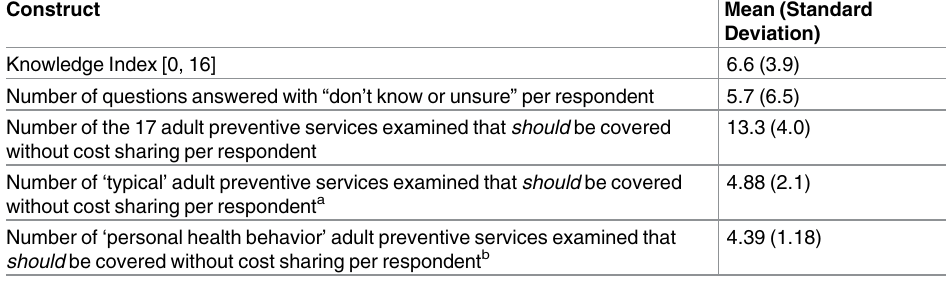
Table 2. Means and standard deviations of key constructs.